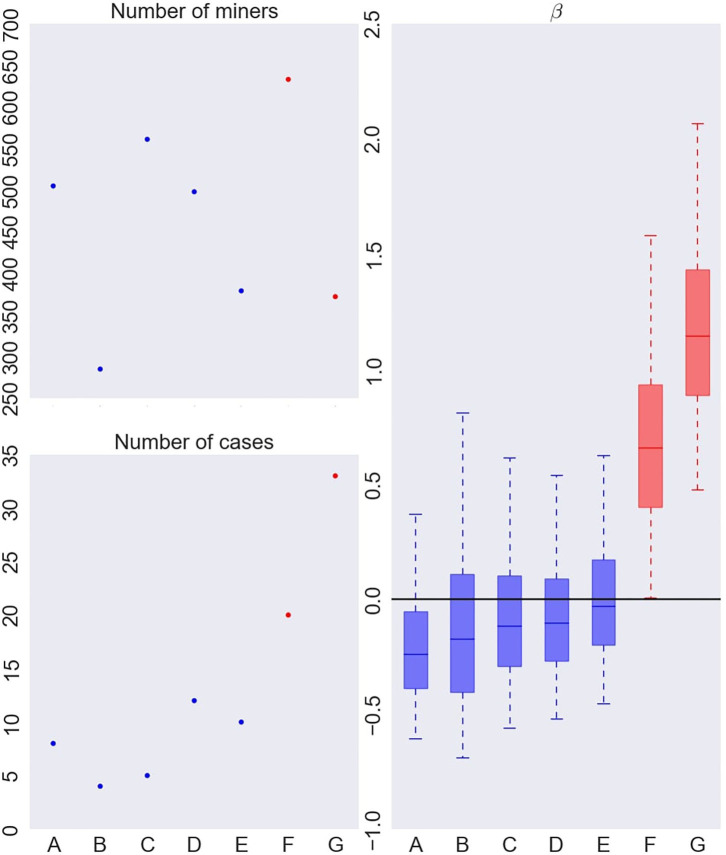
Number of French uranium miners (top left), number of deaths by lung cancer (bottom left) and instantaneous excess hazard ratio (per 100 WLM) of death by lung cancer (β) in each cluster (right), when fitting a Bayesian RPRM model assuming 8 non-empty clusters from the French cohort of uranium miners. The cluster including non-exposed miners is not displayed. The boxes represent the three quartiles (1st quartile, median, and 3rd quartile) of the posterior distribution of β and the whiskers of the boxplots show the 95% credible interval of the posterior distribution for each group.